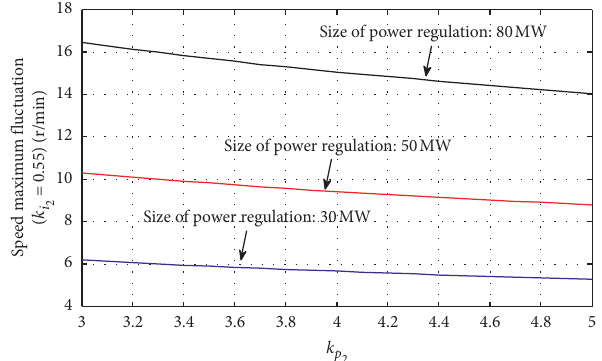
Figure 21: Speed fluctuation caused by the stator side power adjustment with different k p 2